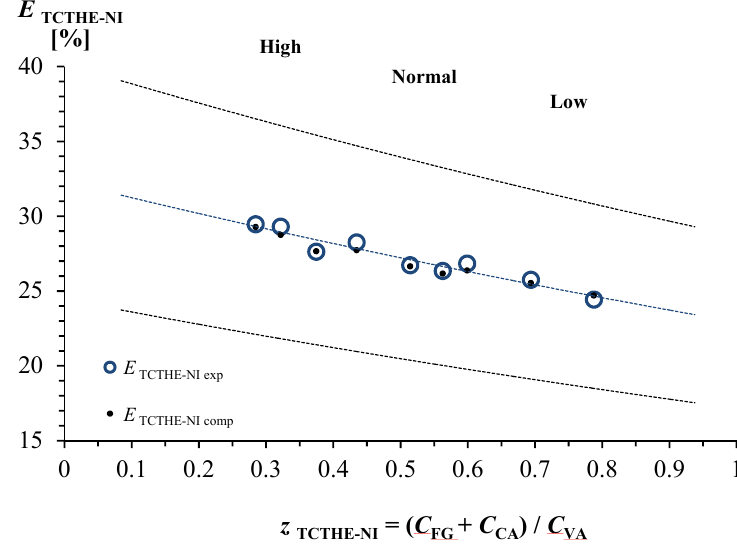
Figure 7. Experimental and computed values of the TCTHE-NI effectiveness.